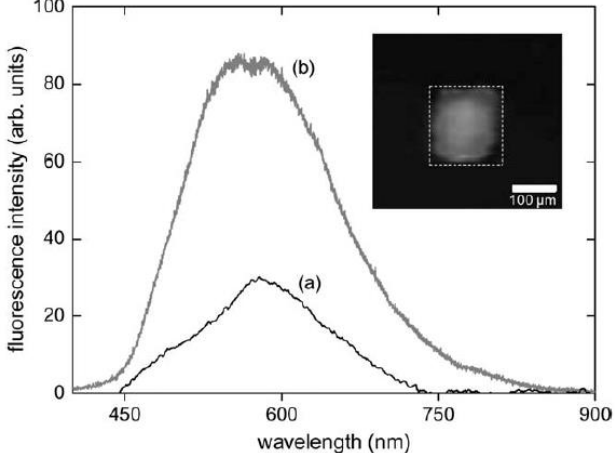
Figure 5. SEM images of two-photon polymerized ZnO nanowires/polymer composite microstructures containing 0.5 ( a ) and 1.0 ( b ) wt % of ZnO nanowires. Reprinted with permission from [65].